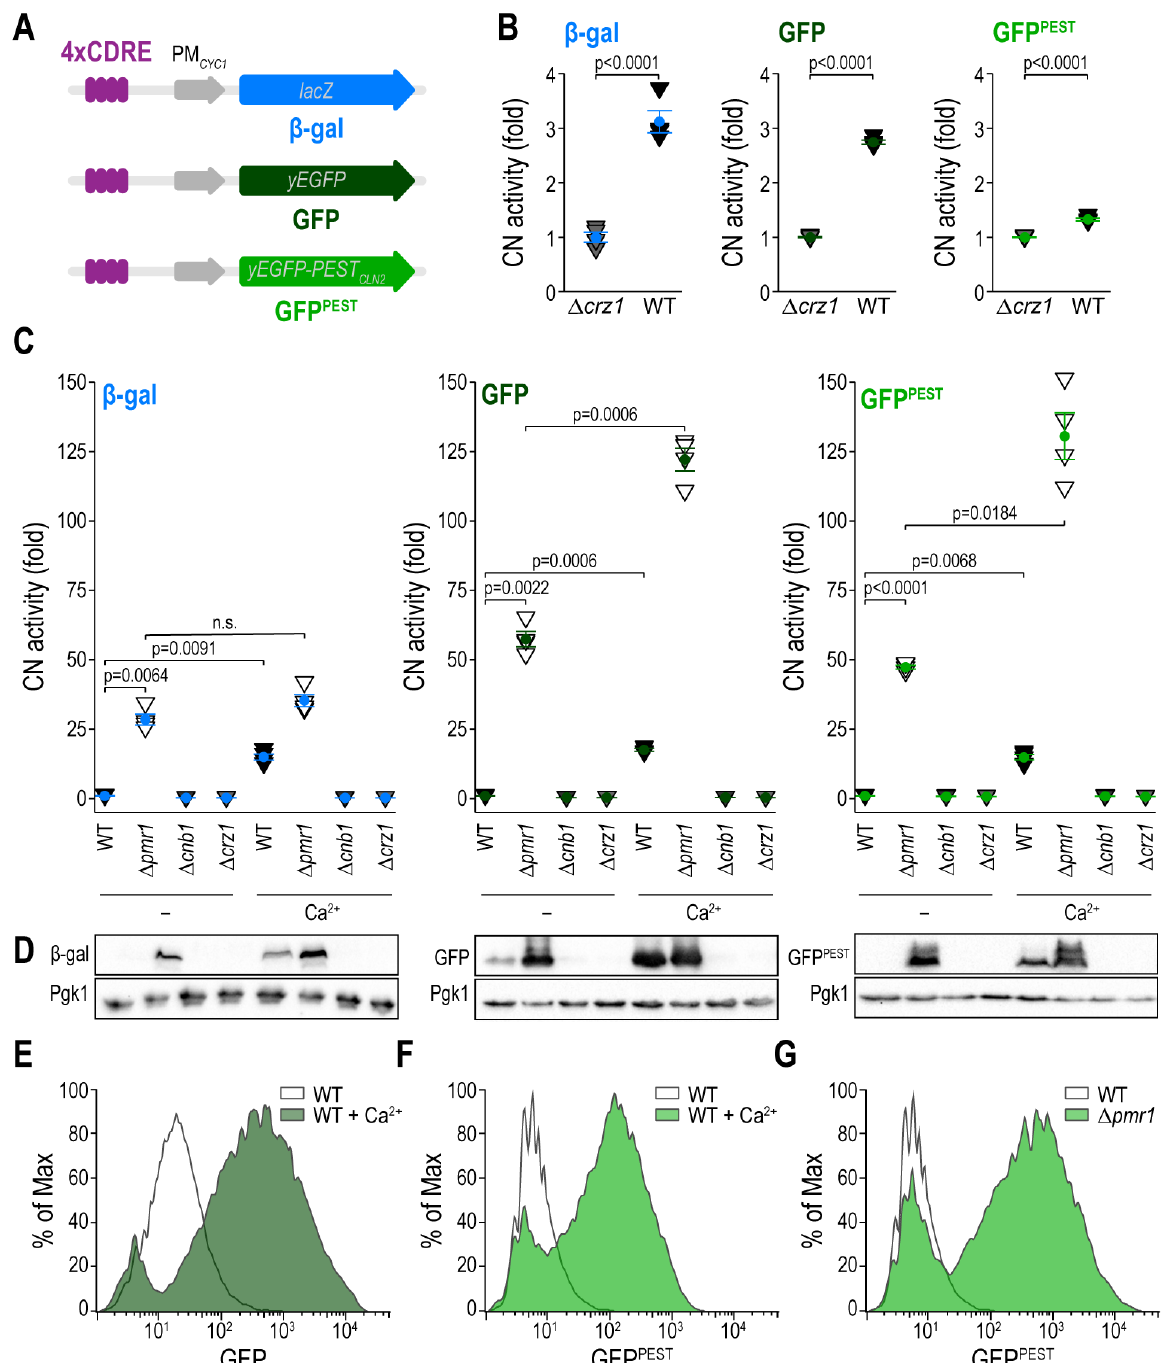
FIGURE 1: GFP and GFP PEST function as reporters of calcineurin activity. (A) Schematics of pAMS366-4XCDRE-lacZ, pAMS366-4xCDRE-GFP and pAMS366-4xCDRE-GFP PEST plasmids encoding reporters for CN activity. (B) CN activity was determined via β -gal activity or via flow cy- tometric quantification of GFP fluorescence intensities in exponentially growing wild type and ∆ crz1 cells equipped with either pAMS366- 4xCDRE-lacZ, pAMS366-4xCDRE-GFP or pAMS366-4xCDRE-GFP PEST . Values are shown as fold of ∆ crz1 cells. Means ± SEM, n = 4. (C) CN activi- ty was measure d as in (B) in exponentially growing wild type, ∆ pmr1 , ∆ cnb1 and ∆ crz1 cells equipped with the indicated reporter plasmid. For stimulation of CN activity, cells were treated with 50 mM Ca 2+ 1 h prior to measurement. Fold of untreated wild type cells is shown. Dead cells were excluded from the analysis via propidium iodide (PI) staining. Means ± SEM, n = 4. (D) Representative immunoblots of pro- tein extracts from cells described in (C). Immunoblots were decorated with antibodies against β -gal or GFP, respectively, and Pgk1 as loading control. (E-G) Histograms of cells quantified in (C) indicating the shift in green fluorescence intensity of wild type cells with and without 50 mM Ca 2+ treatment and ∆ pmr1 cells equipped with the GFP (E) or the GFP PEST reporter (F,